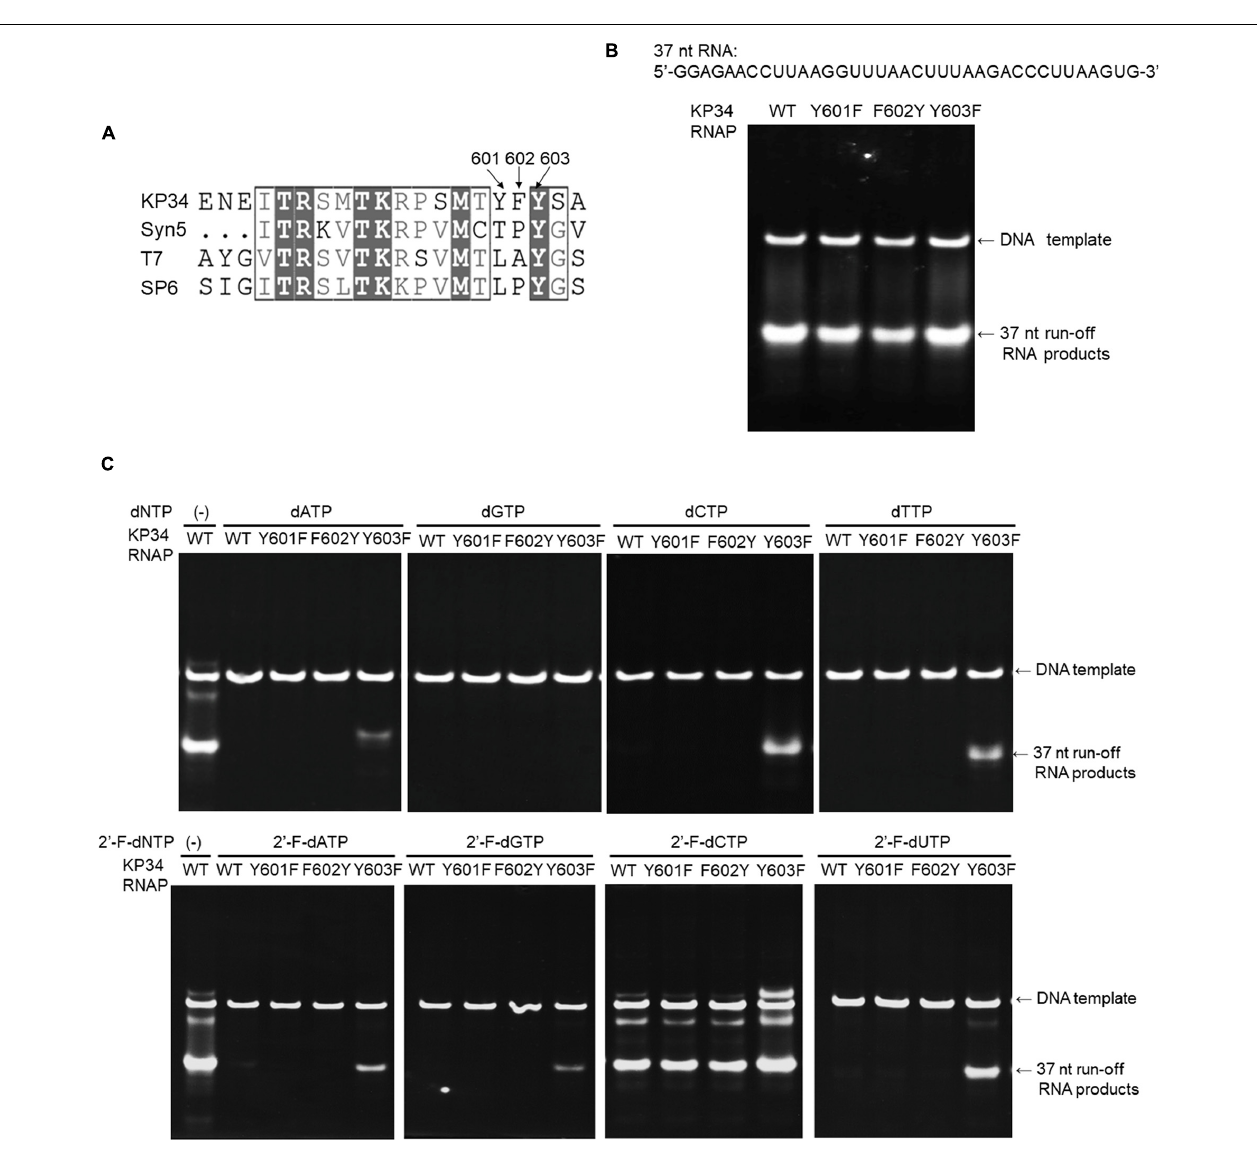
FIGURE 5 | Incorporation of dNMPs and 2 (cid:48) -F-dNMP by wild-type (WT) KP34 RNAP and its Y601F, F602Y, and Y603F mutants. All RNA polymerases in the assays were at the same final concentration 1 µ M. Transcription reaction mixtures were separated by 12% TBE native gel and then stained with ethidium bromide. (A) KP34-Y601F, F602Y and KP34-Y603F RNAPs were constructed based on Multiple Sequence Alignment by ClustalW to the region containing either Y639 in T7 RNAP, Y631 in SP6 RNAP or Y564 in Syn5 RNAP, which were known to control the ribose 2 (cid:48) specificity of each enzyme. (B) Comparison of WT, Y601F, F602Y, and Y603F KP34 RNAPs in synthesis of natural RNA. The 37 nt RNA sequence to be synthesized is at the top of the gel. The enzyme used for each reaction is indicated at the top of each lane. (C) Incorporation of dNMPs and 2 (cid:48) -F-dNMPs into the 37 nt RNA transcripts by WT, Y601F, F602Y, and Y603F KP34 RNAPs. In each reaction, one of the four normal NTP substrates was replaced by the corresponding dNTP or 2 (cid:48) -F-dNTP analog as indicated at the top of the gels.